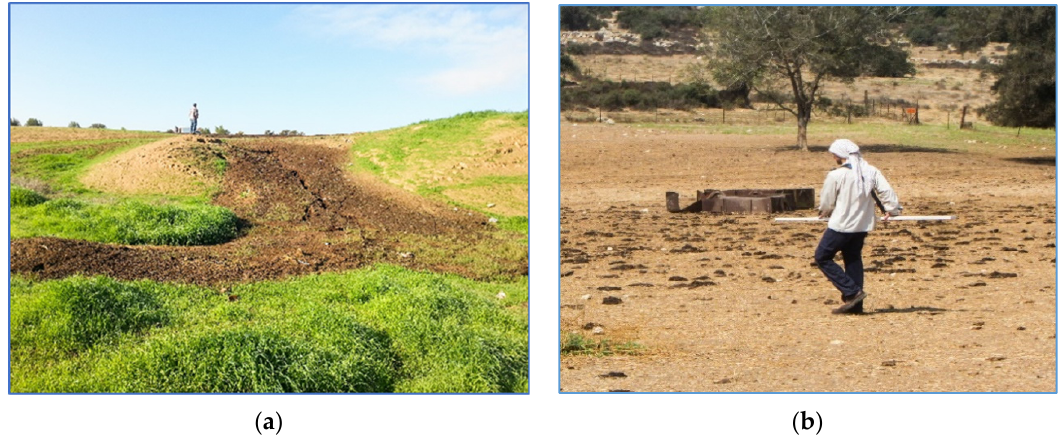
Figure 1. ( a ) Downstream contamination of animal secretions leaking from a sheep corral; ( b ) Gem-2 frequency domain electromagnetic method (FDEM) measurements.